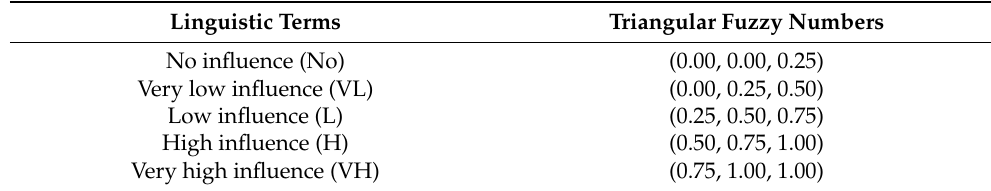
Table 2. Relationship between linguistic terms and triangular fuzzy